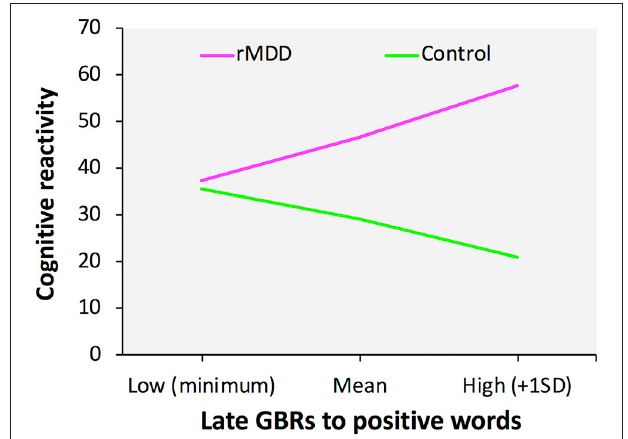
FIGURE 2 | Moderation effects of late gamma-band responses on group and cognitive reactivity. Slope of the relationship between late GBRs to positive words and cognitive reactivity as a function of